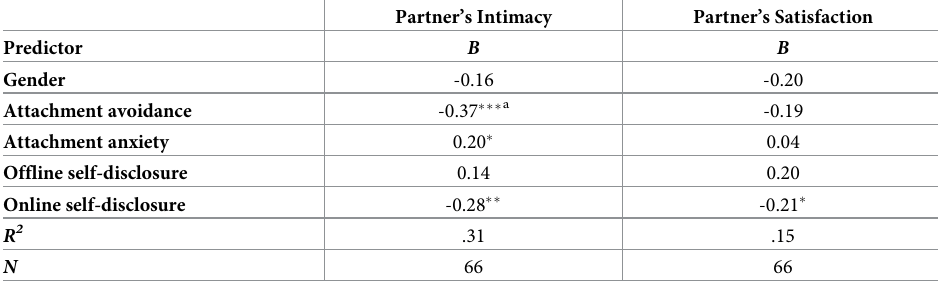
Table 2. Study 2 regression analyses predicting romantic partner’s relationship intimacy and